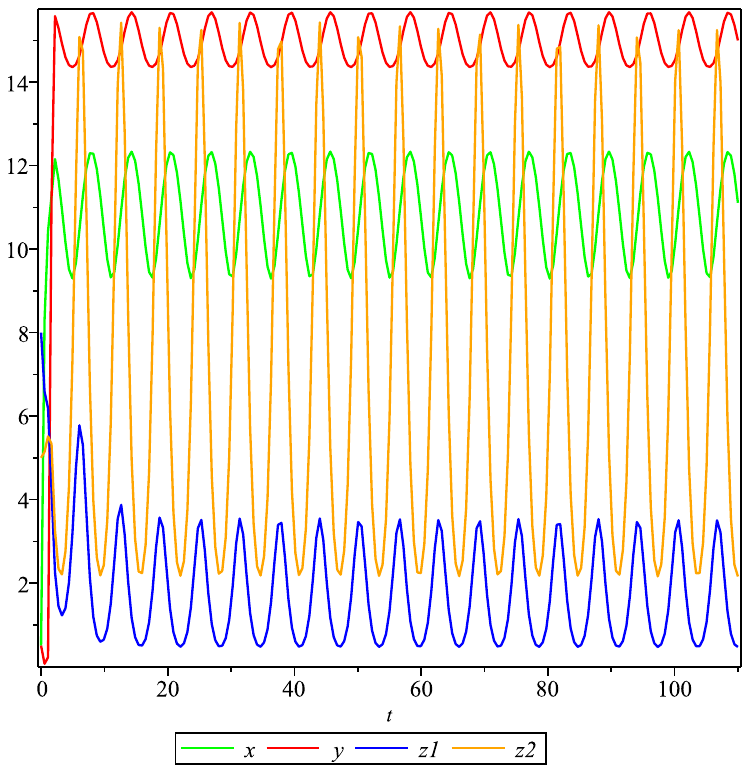
Figure 1. The periodic